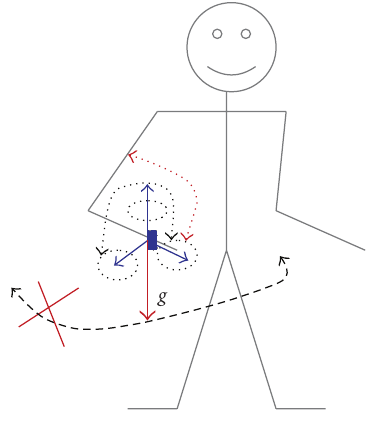
Figure 6: Example of two possible measurable rotation angles.